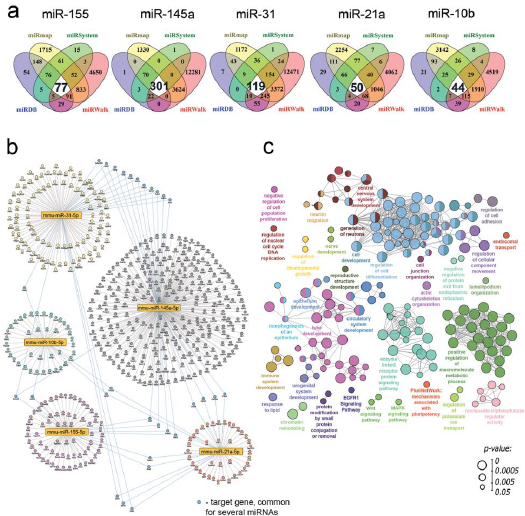
Figure 8. Functional annotation of RNase-A-susceptible miRNAs identified in B16 cells. ( a ) Venn diagram analysis of target genes of five RNase-A-susceptible miRNAs. For each miRNA, target genes were obtained from four independent miRNA databases including miRmap (yellow), miRSystem (green), miRDB (blue) and miRWalk (red). Number of genes common for all analyzed miRNA databases are labeled in white circles with bold numbers. ( b ) The regulome of RNase-A-susceptible miRNAs and their target genes (labeled in bold numbers in Venn diagram depicted in Figure 8a). The network was reconstructed and visualized by Cytoscape 3.9.0. ( c ) The interaction network of significant terms enriched with revealed miRNA target genes. Functional annotation was performed by ClueGO plugin by using GeneOntology (biological processes), KEGG, REACTOME and Wikipath- ways databases. The functionally grouped network was linked based on the kappa score of terms. Only terms/pathways with p < 0.05 after the Bonferroni correction were included in the